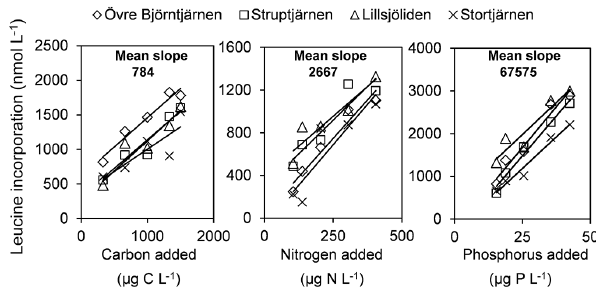
Figure 2. Measurements of leucine incorporation in relation to additions of bioavailable C (as C 6 H 12 O 6 ) , N (NH 4 NO 3 ) , and P (Na 2 HPO 4 ) . Regression equations for all points pooled together: bioavailable C = 784 x + 384 ( R 2 = 0 . 74, p <0.0001; n = 20); bioavailable N = 2667 x + 159 ( R 2 = 0 . 75, p <0.0001, n = 20); bioavailable P = 67575 x − 110 ( R 2 = 0 . 80, p <0.0001, n = 20). Note that each individual regression line in the figure has a better fit than the regression line for all observations